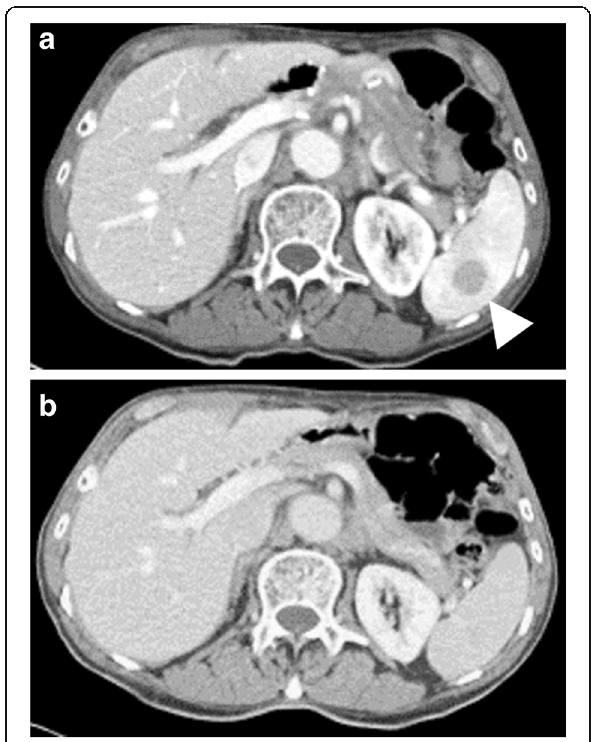
Fig. 2 a The CT scan 6 months after gastrectomy shows the appearance of a low-density lesion that is 17 mm in diameter at the spleen. b Preoperative CT scan shows no lesion at the spleen